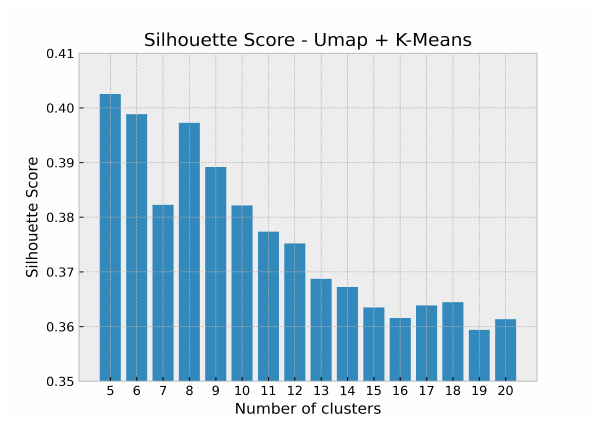
Figure 2. Silhouette Score of UMAP+k-Means as a function of the number of clusters for HRL000040FF dataset.